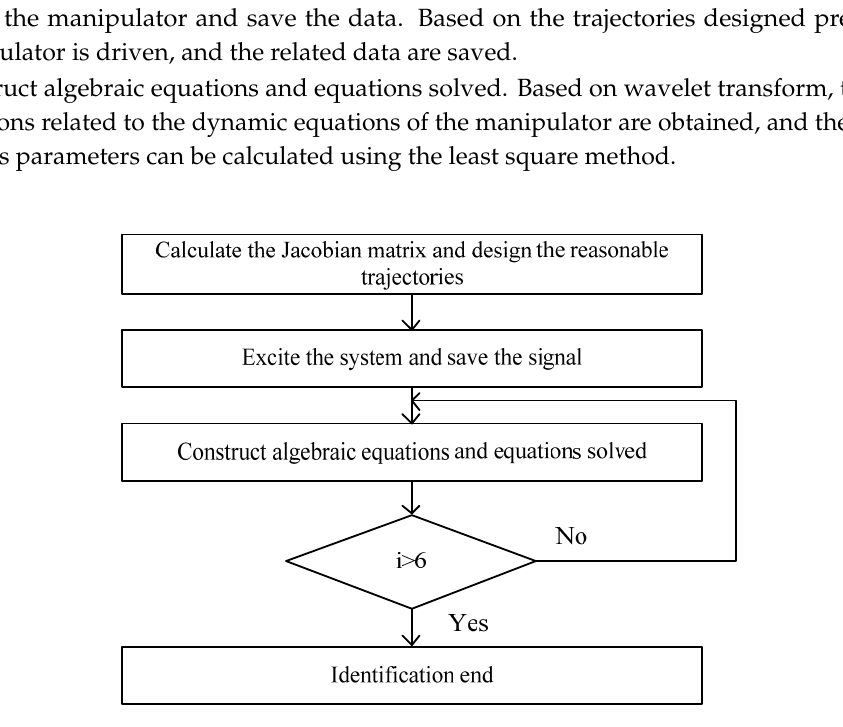
Figure 2. The flowchart of the identification method based on wavelet transform.